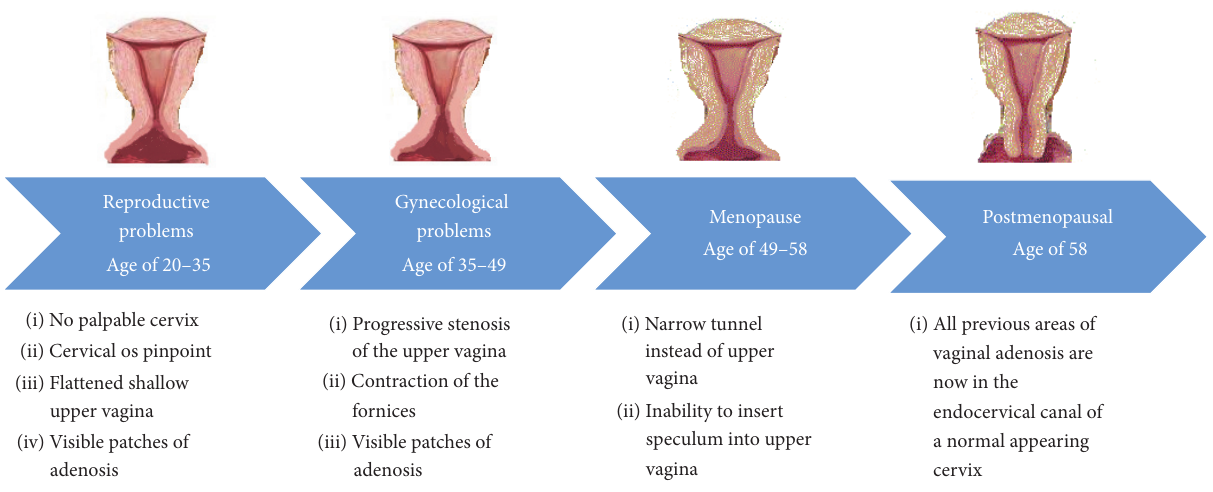
cranial portion of the vagina is really uterine mesenchyme in